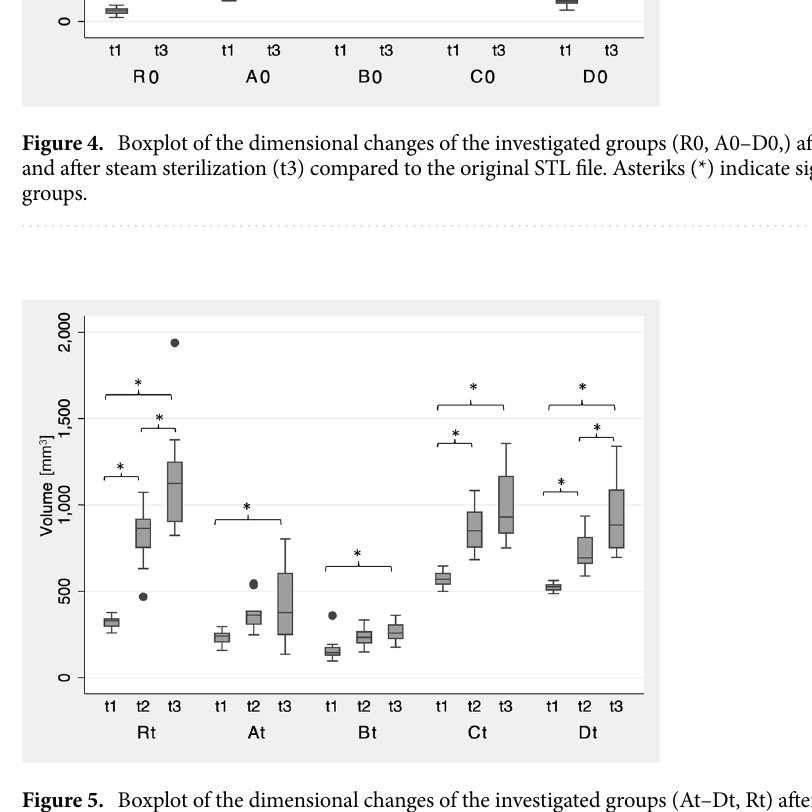
Figure 5. Boxplot of the dimensional changes of the investigated groups (At–Dt, Rt) after 3D printing (t1), annealing (t2), and steam sterilization (t3) compared to the original STL file. Asteriks (*) indicate significances within the